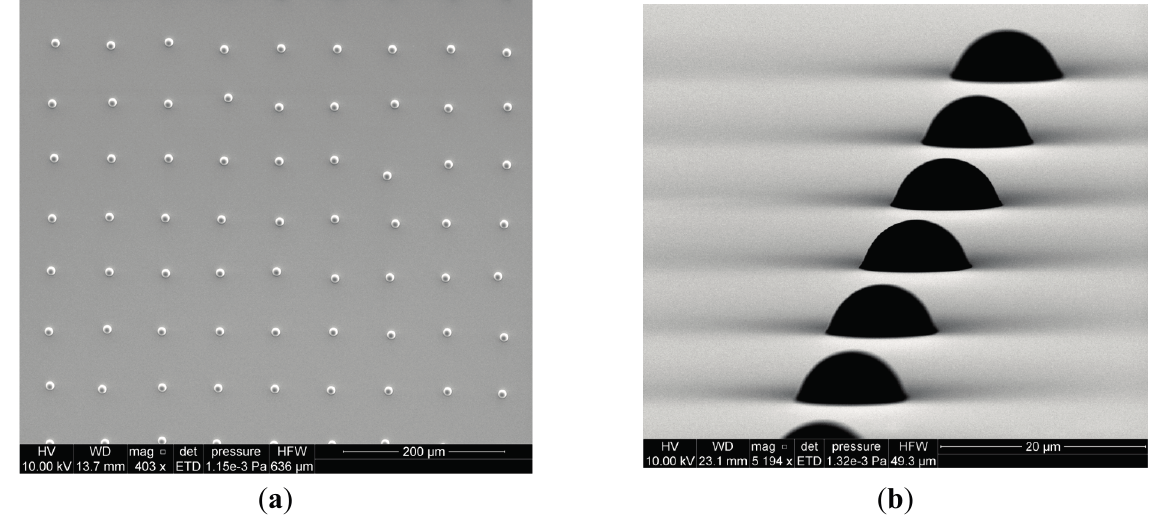
Figure 5. ( a ) Printed array of inorganic salt particles containing multiple elements in 3% nitric acid solution. The standard solution contains Ca, Mg, K, Li, Na, Cr, B, Fe, Mn, K, Au, Zn, Al, Cu, Ni, 6 Li, 204 Pb, 25 Mg, 54 Fe, 50 Cr, 10 B at concentrations ranging from 50 to 1000 μ g/mL; ( b ) High tilt scanning electron micrograph of several particles from the array.